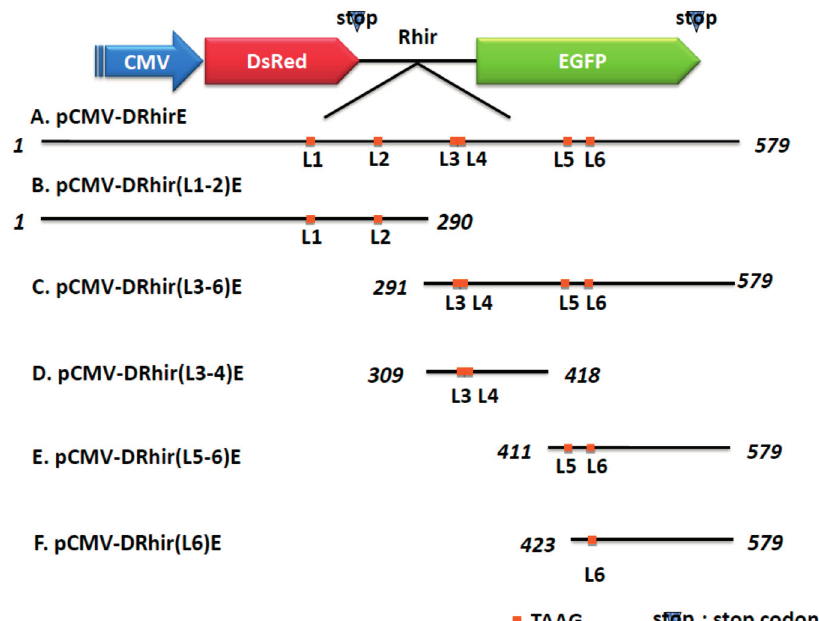
Figure 1. Schematic presentation of the truncated version of the RhPV 5 ′ IRES and bicistronic constructs. The indicated cDNA fragments were generated by PCR and inserted between the DsRed and EGFP genes in the bicistronic vector ( A ) pCMV-DRhirE which containing the completed 579 bps of RhPV IRES cDNA fragment and the six TAAG motifs are denoted with L1-6, respectively; ( B ) pCMV-DRhir(L1-2)E which containing the 1–290 bps of RhPV IRES cDNA fragment with the L1 and L2 TAAG motifs; ( C ) pCMV-DRhir(L3-6)E which containing the 291–579 bps of RhPV IRES cDNA fragment with the L3-L6 TAAG motifs; ( D ) pCMV-DRhir(L3-4)E which containing the 309–418 bps of RhPV IRES cDNA fragment with the L3 and L4 TAAG motifs; ( E ) pCMV-DRhir(L5-6)E which containing the 411–579 bps of RhPV IRES cDNA fragment with the L5 and L6 TAAG motifs; ( F ) pCMV-DRhir(L6)E which containing the 423–579 bps of RhPV IRES cDNA fragment with only the L6 TAAG